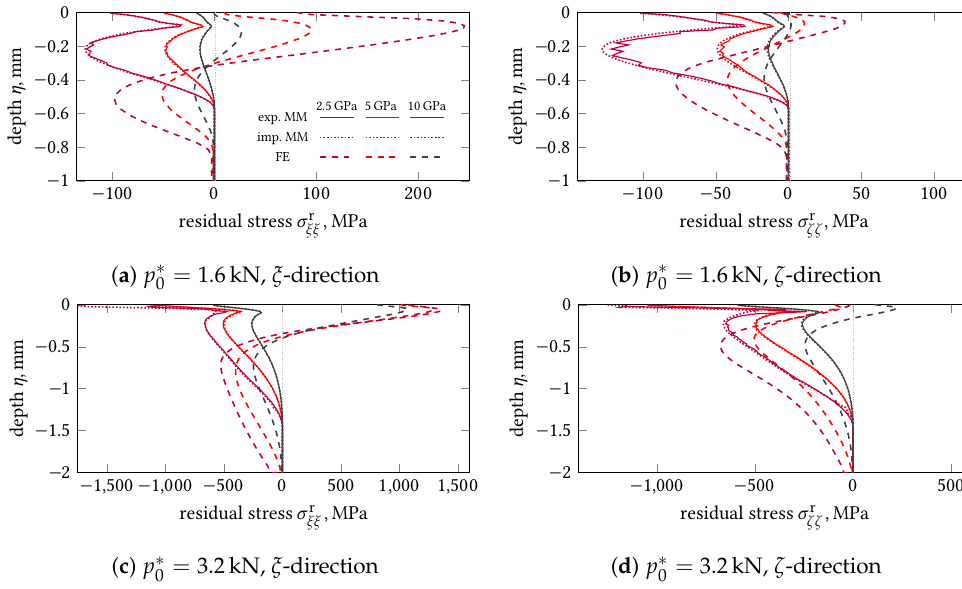
Figure 11. Residual stresses computed by the MM method vs. the results computed by the FEM for various values of the plastic-hardening parameter h and the two considered load levels p ∗